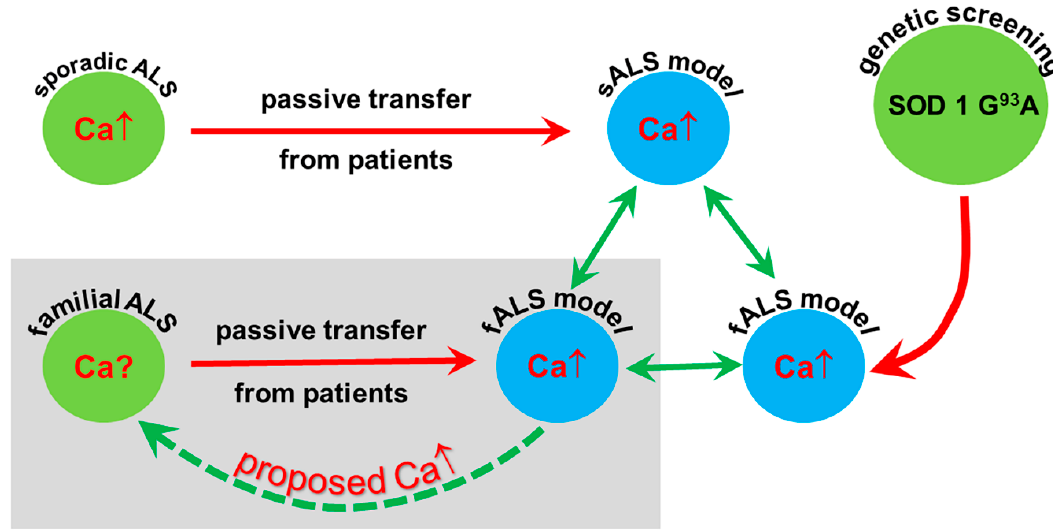
Figure 1. Amyotrophic lateral sclerosis (ALS) patients are represented with green circles, and the ALS models are symbolized with blue circles. With the passive transfer of serum or immunoglobulin G (IgG) from sporadic patients to mice (red arrow), a model of sporadic ALS could be created which reproduces the elevated calcium in the motor axon terminals demonstrated in the patients. A transgenic model of familial ALS, based on the mutations identified in patients, could also be created (curved red arrow). By replicating the sporadic ALS model with the passive transfer of sera from familial patients (shaded area), another model of familial ALS was set up in the present study. Since in each model comparable increases of calcium in the motor axon terminals could be demonstrated (green arrows), an elevated calcium level in the motor axon terminals, similar to that seen in sporadic patients, could be hypothesized for the familial ALS patients (dashed green arrow).